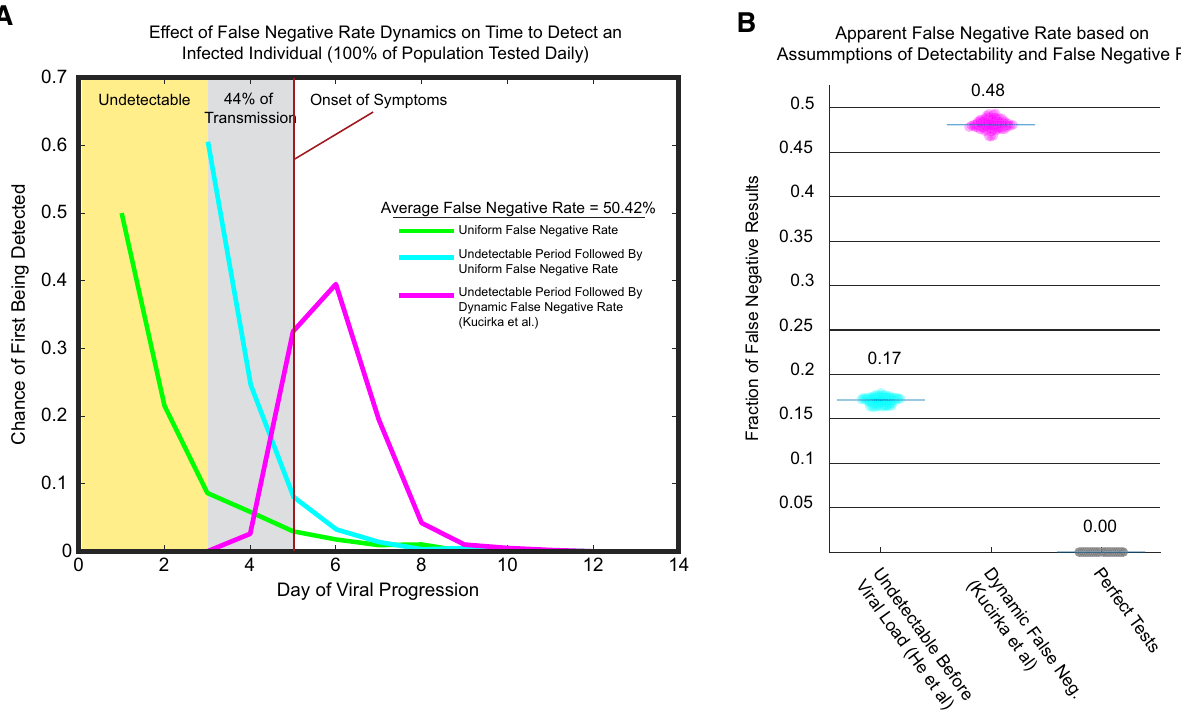
Figure 4. Effects of False Negative rates on detection. ( A ) Non-uniform false negative dynamics can delay detection of infected individuals. Shown is the chance of first being detected at each day of disease progression based on three scenarios with the same average false negative rate across the 14 days shown, but different temporal dynamics. For this graph, we assume that symptom onset begins at day 5. In yellow is the undetectable period prior to 2 days before symptom onset. The two days before symptom onset is shown in gray. Viral load data suggests that as much as 44% of transmissibility may occur in these two days. The line represents histograms of the first day that an individual would be detected by a daily test with the given false negative rate dynamics. ( B ) The undetectable period and temporal dynamics of the false negative rate lead to high apparent false negative rates. The first day of the model was run 100 times with 10,000 sick individuals. In cyan we show the model run with the simple assumption that infected individuals were undetectable before viral load begins, (2 days prior to symptom onset, based on the He et al. data 6 ), and that after that point the tests will always detect infected individuals. In magenta, the model uses the dynamic false negative rates from Kucirka et al. 7 , in which both test error and inability to detect due to low viral load are mixed together. Also included as a comparison is the effect of perfect tests shown in